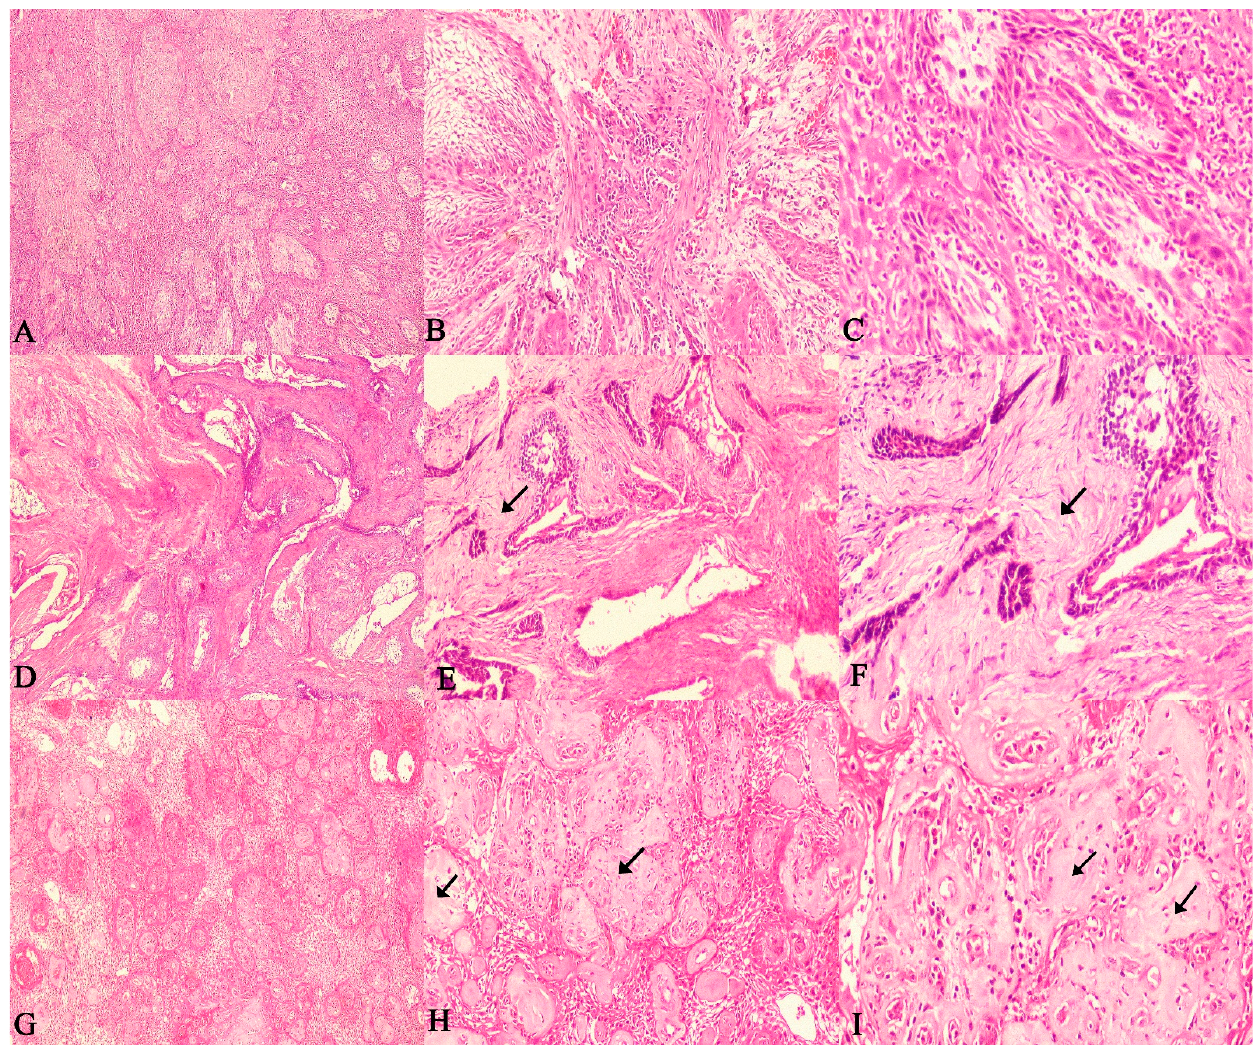
Figure 5. Photomicrographs of haematoxylin and eosin stain. Plexiform ameloblastoma with a non-hyalinized stroma ( A ). 40×, ( B ). 100× and ( C ). 400× (non-recurrent case). Ameloblastoma exhibiting moderate juxta-epithelial and stromal hyalinization zones between odontogenic epithelium ( D ). 40×, ( E ). 100× and ( F ). 400× (recurrent case). Plexiform ameloblastoma exhibiting extensive (increased SOH) juxta-epithelial and stromal hyalinization zones between odontogenic epithelium ( G ). 40×, ( H ). 100× and ( I ). 400× (recurrent case). (Non-hyalinized: no evidence of hyalinization; mild: few areas of hyalinization; moderate: considerable areas of hyalinization; severe: extensive areas of hyalinization). (Arrows indicate hyalinized areas)